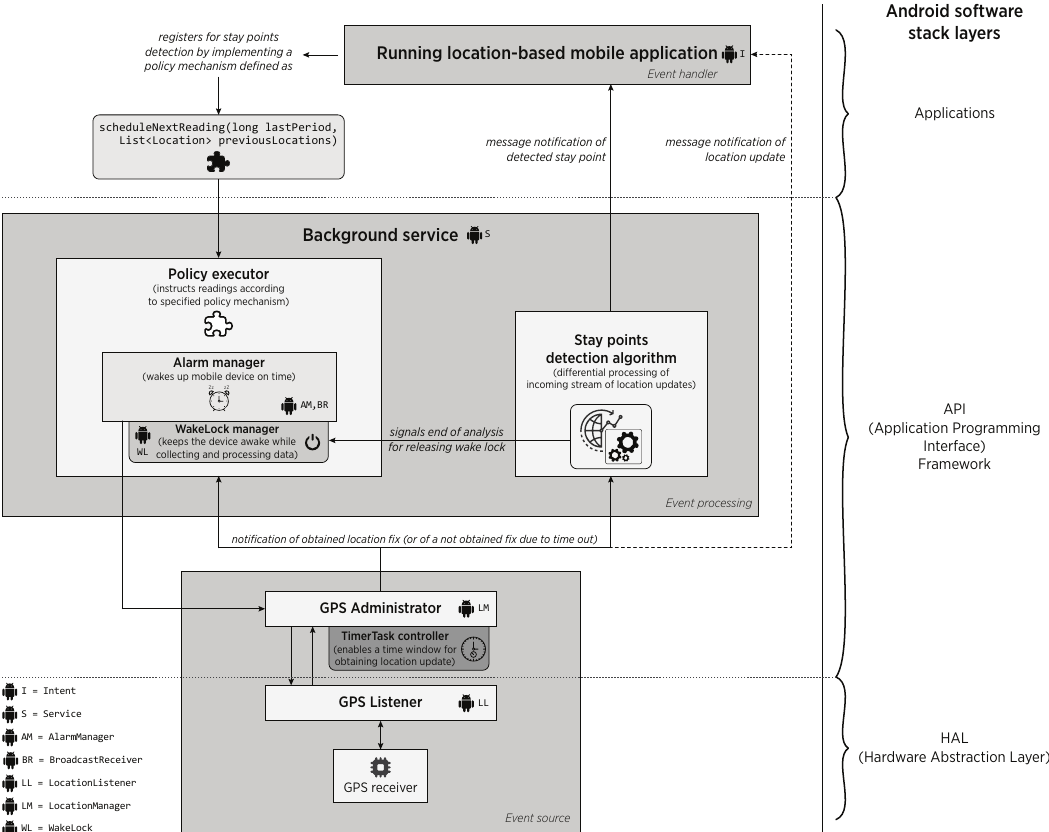
Figure 3. Architecture of the proposed middleware for GPS data collection and on-device stay points